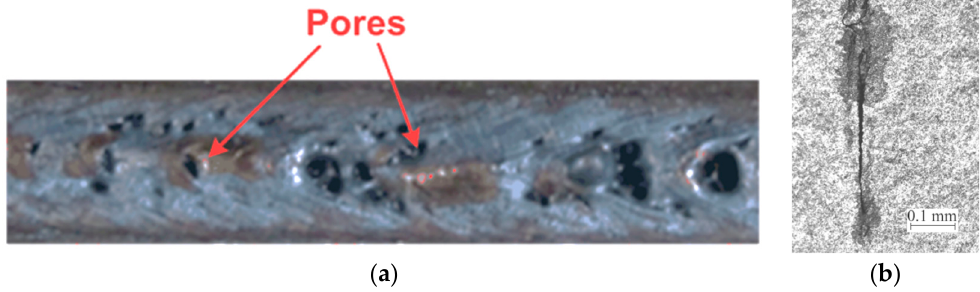
Figure 12. Imperfections of hybrid laser welding: ( a ) pores (reproduced from [75] with permission, Springer London, 2017), and ( b ) crack (reproduced from [79] with permission, Elsevier, 2016).